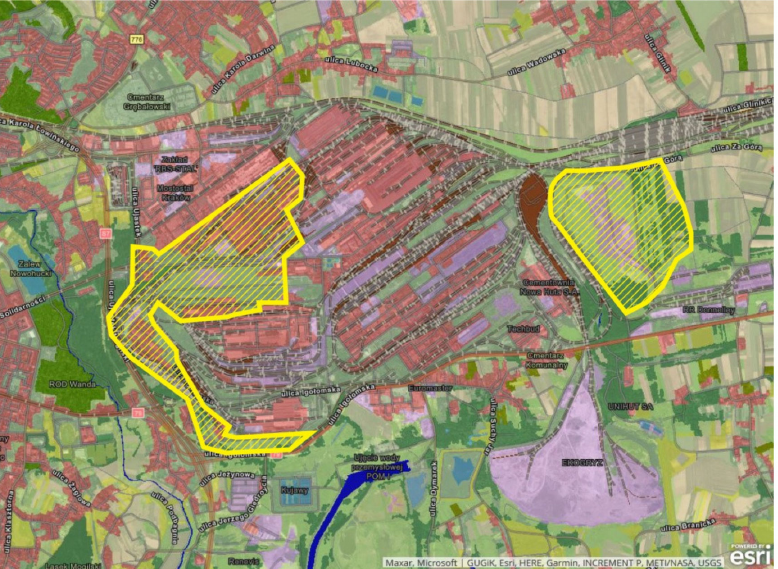
Figure 8. Areas taken over by the city and designated for urban functions and structures (marked in yellow on the background—Monit-air Atlas of Cracow